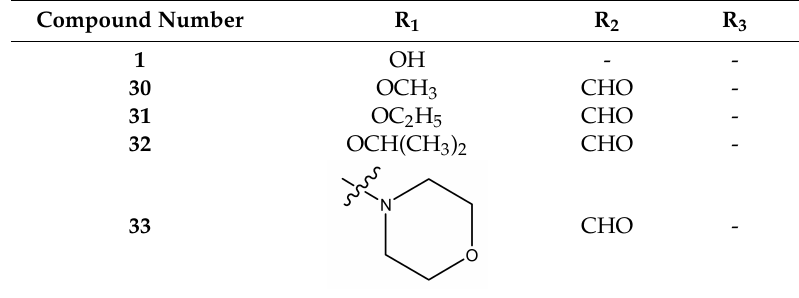
Figure 3. Modification of UA yielded amides and ester derivatives. Reagents and conditions: (d) anhydride / Pyridine / N , N -dimethyl-4-aminopyridine (DMAP); (e) CH 3 (CH 2 ) n Br, K 2 CO 3 , (CH 3 ) 2 NCH; (f) rhodium carbonyl chloride ((CO) 2 Cl), dichloromethane (CH 2 Cl 2 ); (g) CH 2 Cl 2 , triethylamine (Et 3 N), HR; (h) NaOH, methanol (CH 3 OH) / tetrahydrofuran (THF). All the reactions were carried out at room temperature. Table 2. Some novel analogues derived, corresponding with Figure 6,